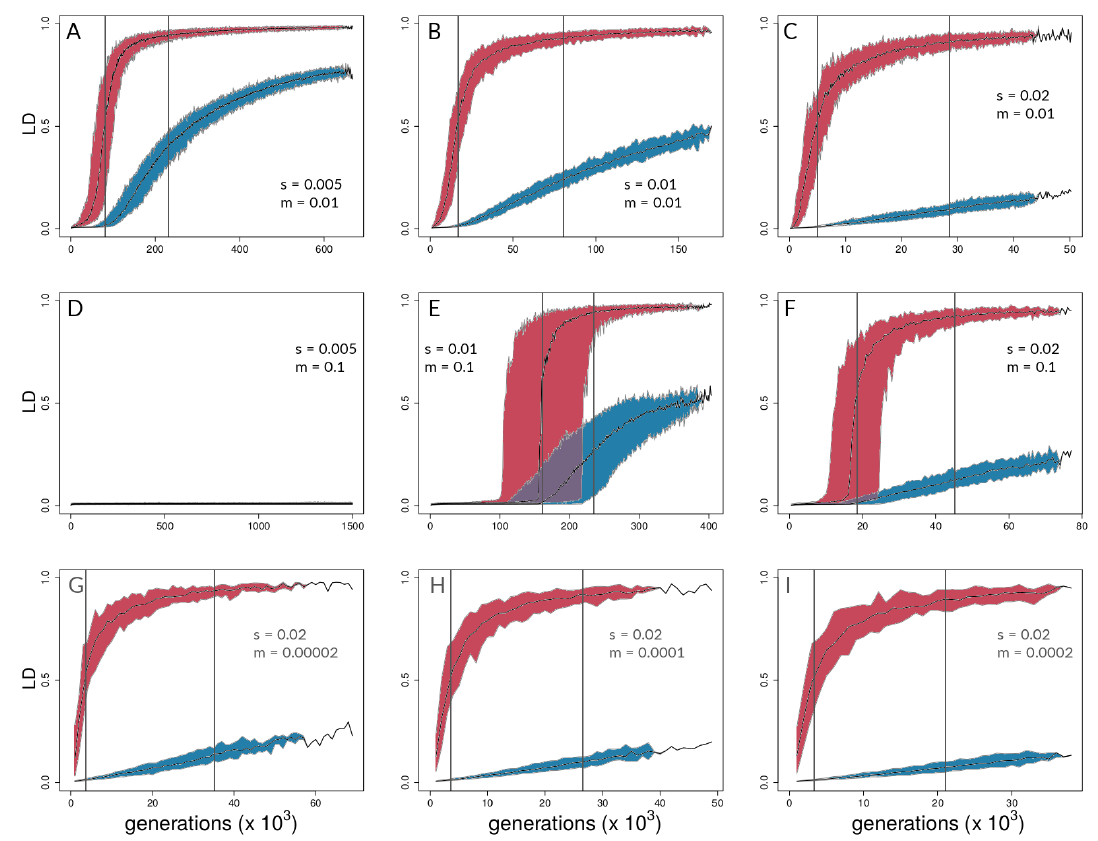
Figure 5. Time series of between-deme linkage disequilibrium (LD) for the same combinations of s and m as in Figure 4. Each plot (A – I) shows the median LD values across 50 independent simulation runs and 95% quantiles (for simulation medians) for selected (red) and neutral sites (blue). Grey lines indicate the point of highest slope by nonlinear least squares model fitting for medians across the 50 respective runs (Table S3 for details).